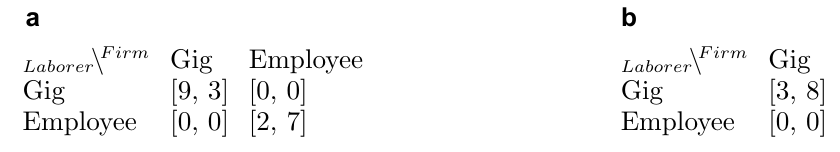
Figure 1 Theoretical GameState Pair Payo↵ Matrices Used in Demonstrations Figure 1. Theoretical GameState pair payoff matrices used in demonstrations. ( a ) Bear market GameState; ( b ) bull market